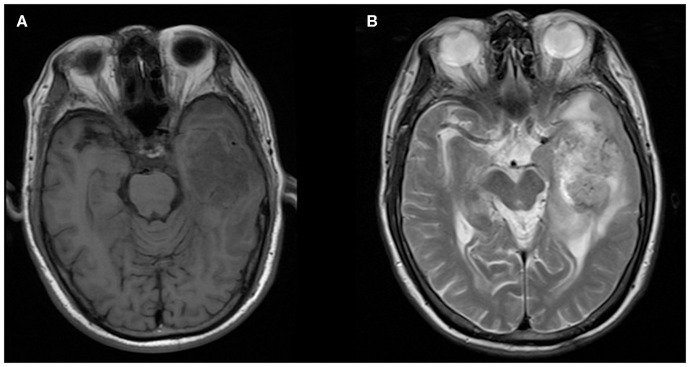
A 76-year-old man with supratentorial intraparenchymal anaplastic ependymoma in the left temporal lobe on (A) T1-weighted image and (B) T2-weighted image. The tumor appears as heterogeneous signal intensity and moderate peritumoral edema.